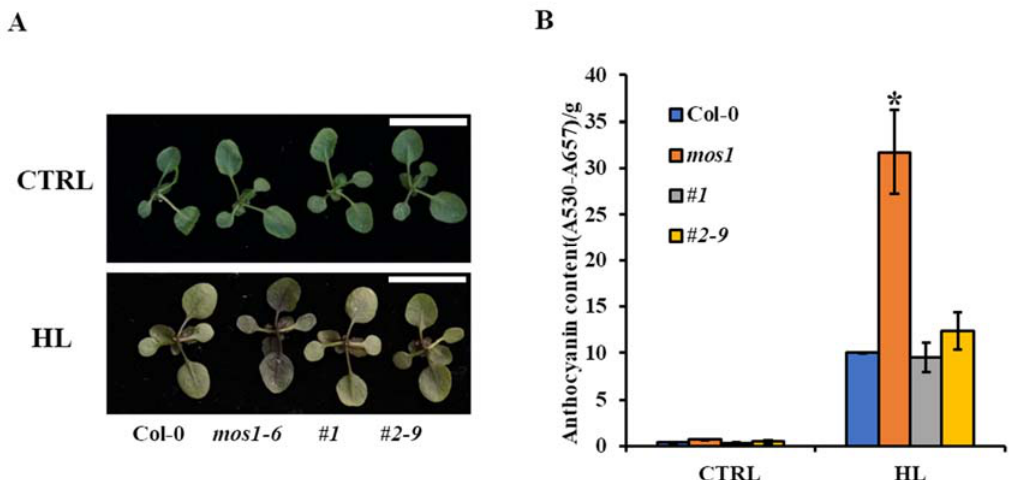
Figure 5. Anthocyanin accumulation under high light in different lines. ( A ) Representative images of the phenotypes of Col-0 and mos1 , #1 , and #2–9 grown in soil after high-light treatment. Scale bars = 1 cm. ( B ) Anthocyanin content in the seedlings of Col-0 and mos1 , #1 , and #2–9 grown in soil under high light (HL) or normal light (as CTRL). Error bars indicate the standard deviation (SD) of three measurements. The asterisk indicates a significant difference compared with Col-0 under the same treatment (one-way ANOVA / Bonferroni p < 0.001).